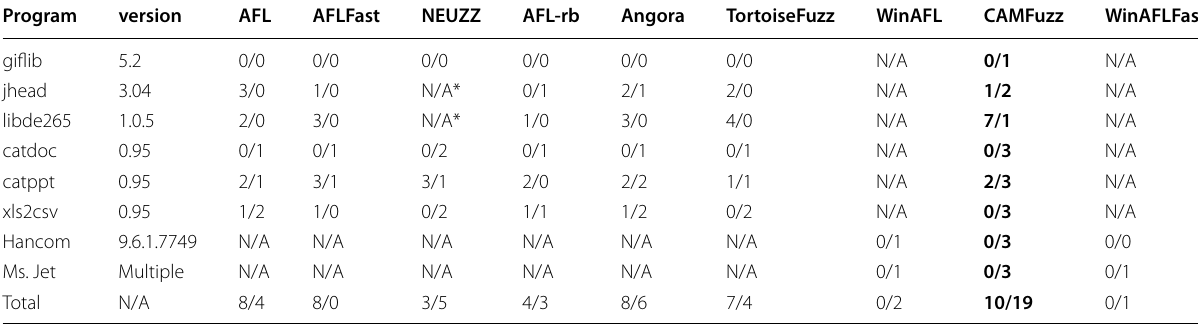
*The fuzzer failed to run on the target over the whole run